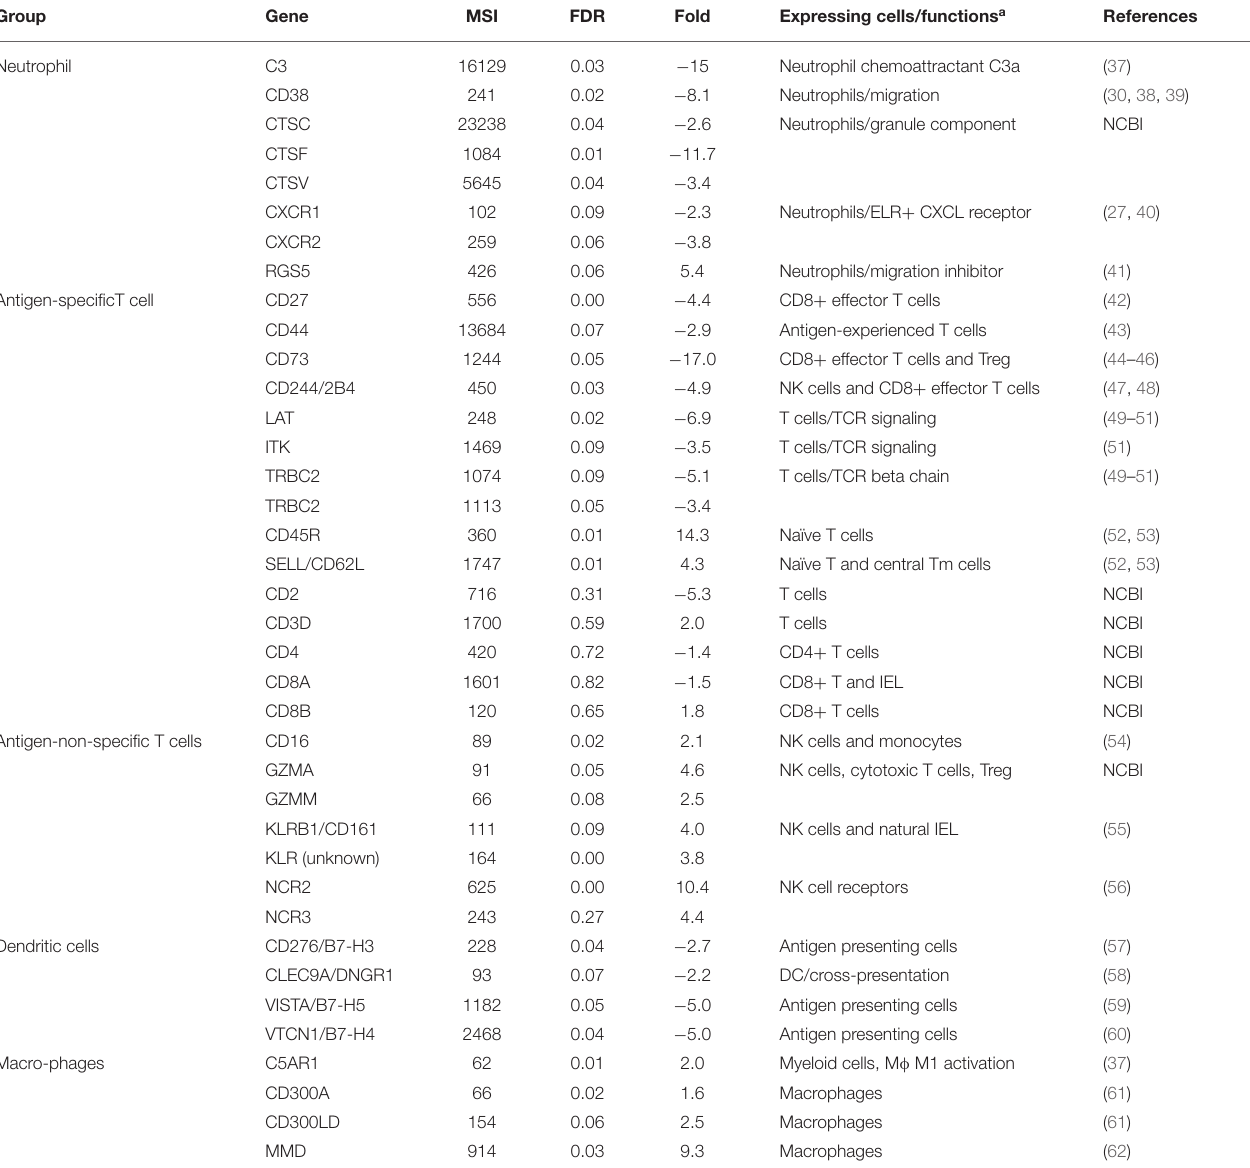
TABLE 3 | Mean expression levels (microarray signal intensity, MSI), false discovery rates (FDR) and fold differences ( + and – values as up- and down-regulated in carriers compared to non-carriers, respectively) of differentially expressed genes supporting decreased numbers of neutrophils, antigen-experienced T cells and dendritic cells and increased number of naïve and natural intraepithelial